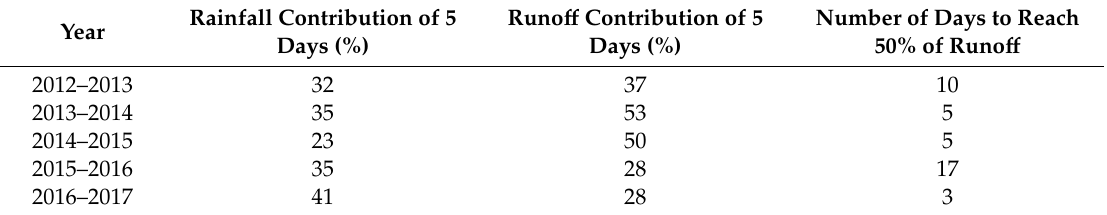
Table A2. Relative rainfall and R contribution of the highest 5 days and number of days to reach the 50% of R for each hydrological year in the Es Fangar Creek.